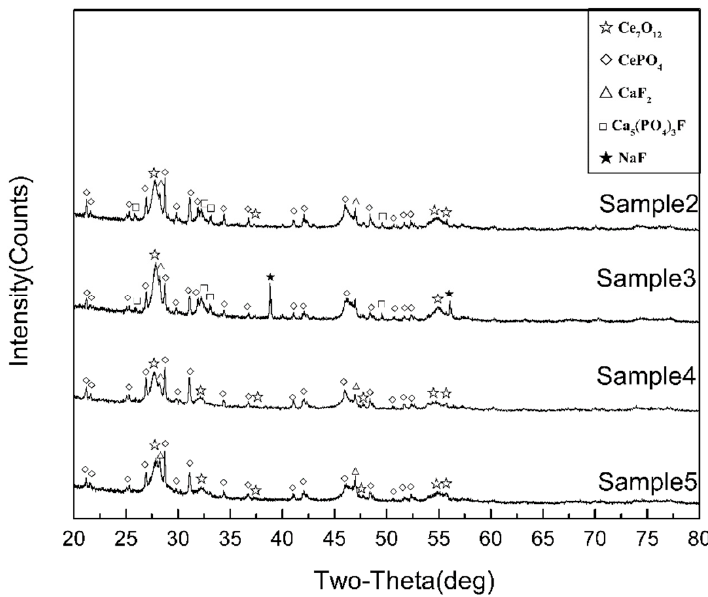
Figure 3. XRD patterns of the modified rare earth concentrates after calcination.